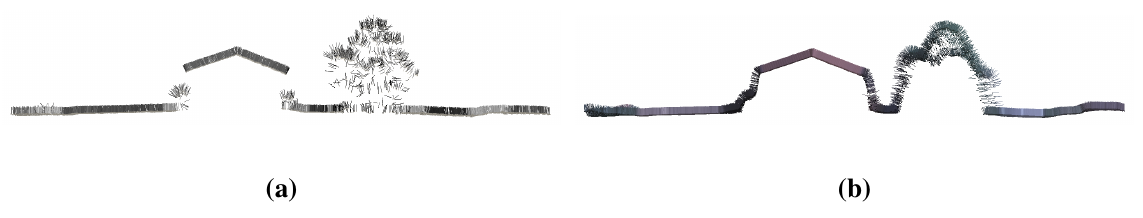
Figure 2. Profile of estimated normal vectors. ( a ) LiDAR data; ( b ) dense